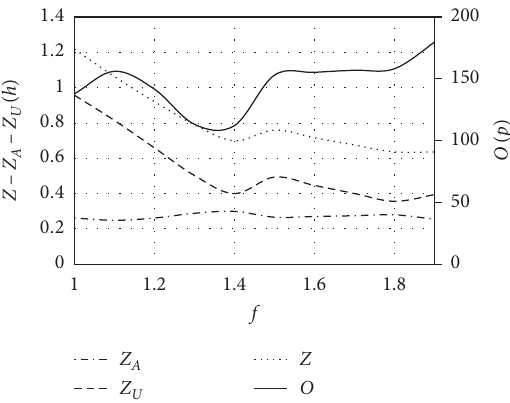
Figure 2: Change of the objective function with f .